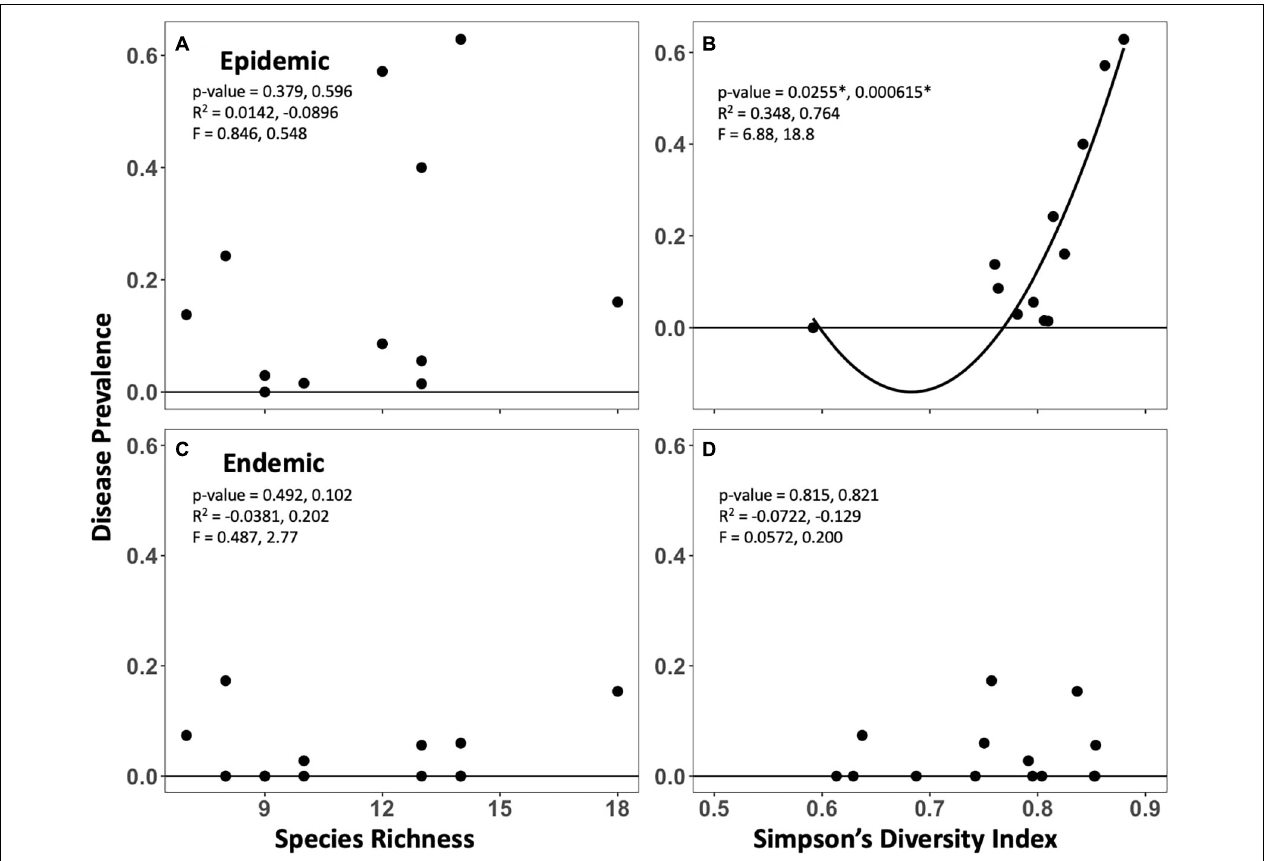
FIGURE 4 | Relationships between disease prevalence (2020) and pre-outbreak species richness (A,C) and Simpson’s Diversity Index (B,D) within the epidemic (top) and endemic (bottom) zones. Primary values reported are for a linear relationship, secondary values are for the shown quadratic